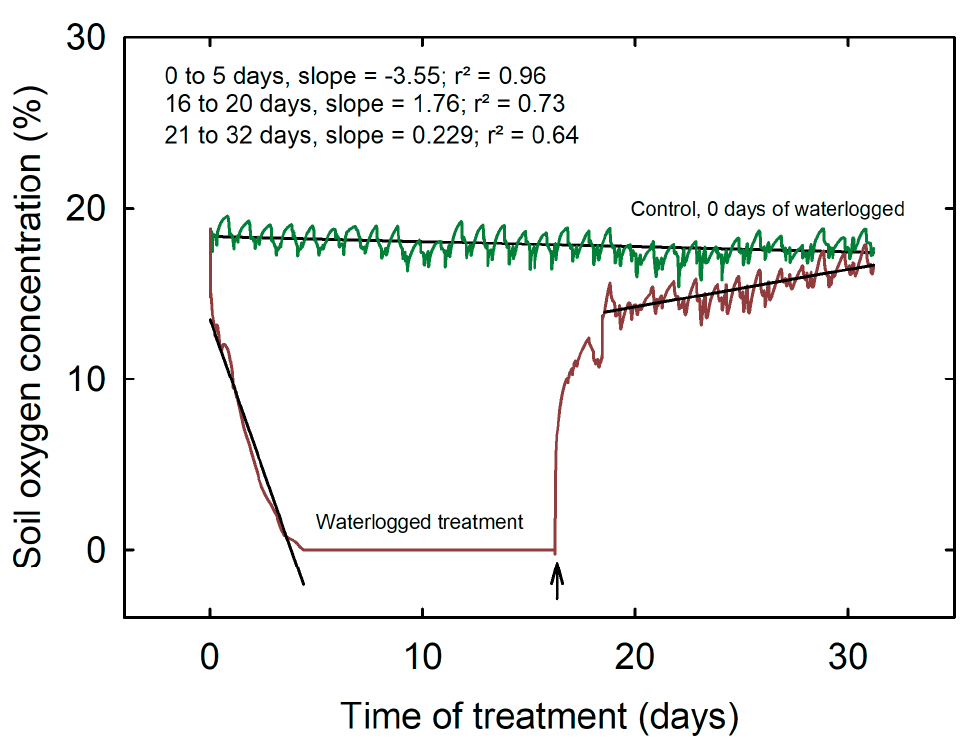
Figure 1. Soil oxygen concentration across waterlogging and control treatments during the experi- mental period of 32 days. The arrow indicates the day that waterlogging treatment was stopped, and the recovery period started. Table 1. Analysis of variation across the waterlogging treatment, the time during waterlogging treatment, and the interaction between treatment and time for soybean physiological traits at the reproductive stage.